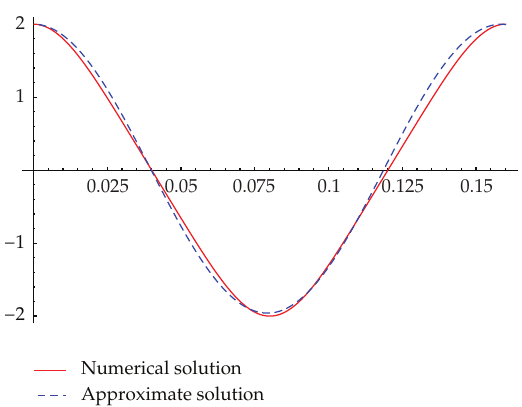
Figure 3: Comparison between the numerical solution of (cid:2) 1.1 (cid:3) and the approximate solution (cid:2) 3.10 (cid:3) for (cid:9) 200, k (cid:9) 1000, q (cid:9) 0 . 1, ω A (cid:9) 2, m (cid:9) 2, k 1 2